Question: Summarize what this figure shows in one sentence.
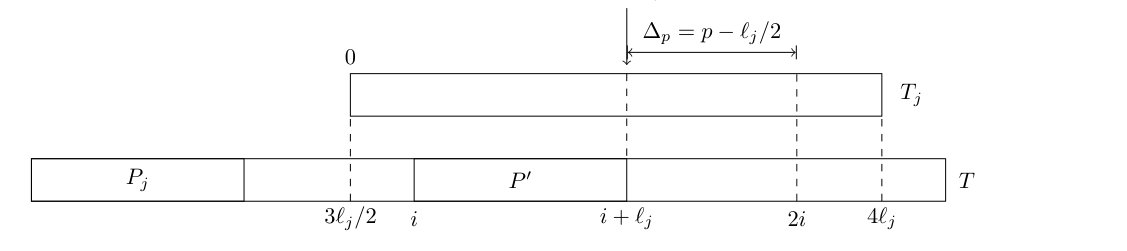
Answer: Illustration of our filtering procedure. Here, P ′ is a k-mismatch occurrence of Pj at position i + ℓj in T and position p = i −ℓj/2 in Tj, reported with delay ∆p = p −ℓj/2 in Tj, hence it arrives at time 2i in T.